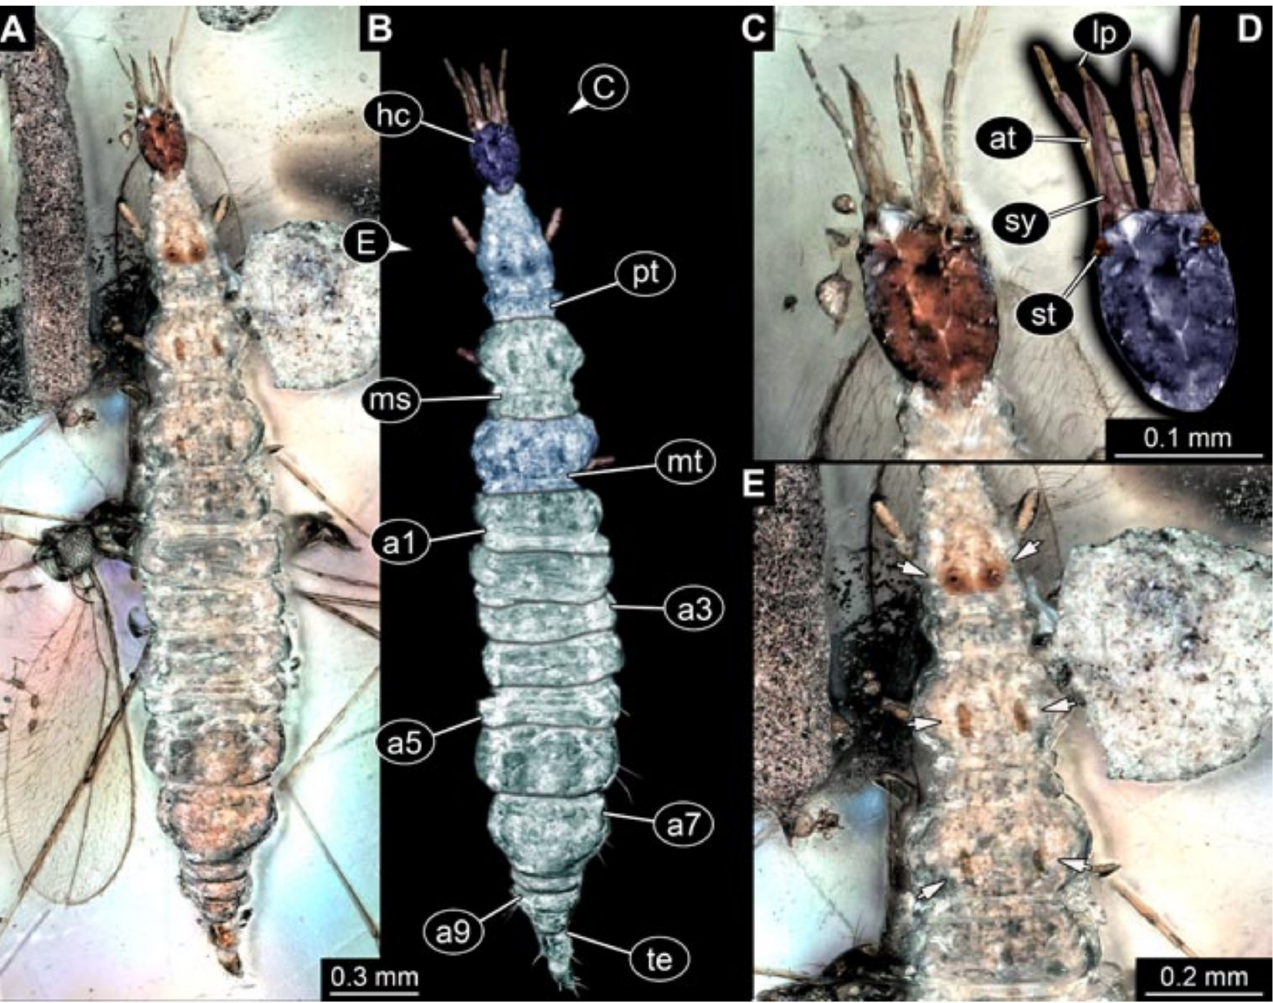
Figure 6. Specimen 5826 (BUB 3144); Myanmar amber. ( A ) Dorsal view. ( B ) Dorsal view, colour-marked. ( C ) Close-up of head capsule in dorsal view. ( D ) Close-up of head capsule in dorsal view, colour-marked. ( E ) Close-up of anterior trunk region with dark patches (arrows) in dorsal view. Abbreviations: a1–a9 = abdomen segments 1–9; at = antenna; hc = head capsule; lp = labial palp; ms = mesothorax; mt = metathorax; pt = prothorax; st = stemmata; sy = stylet; te = trunk